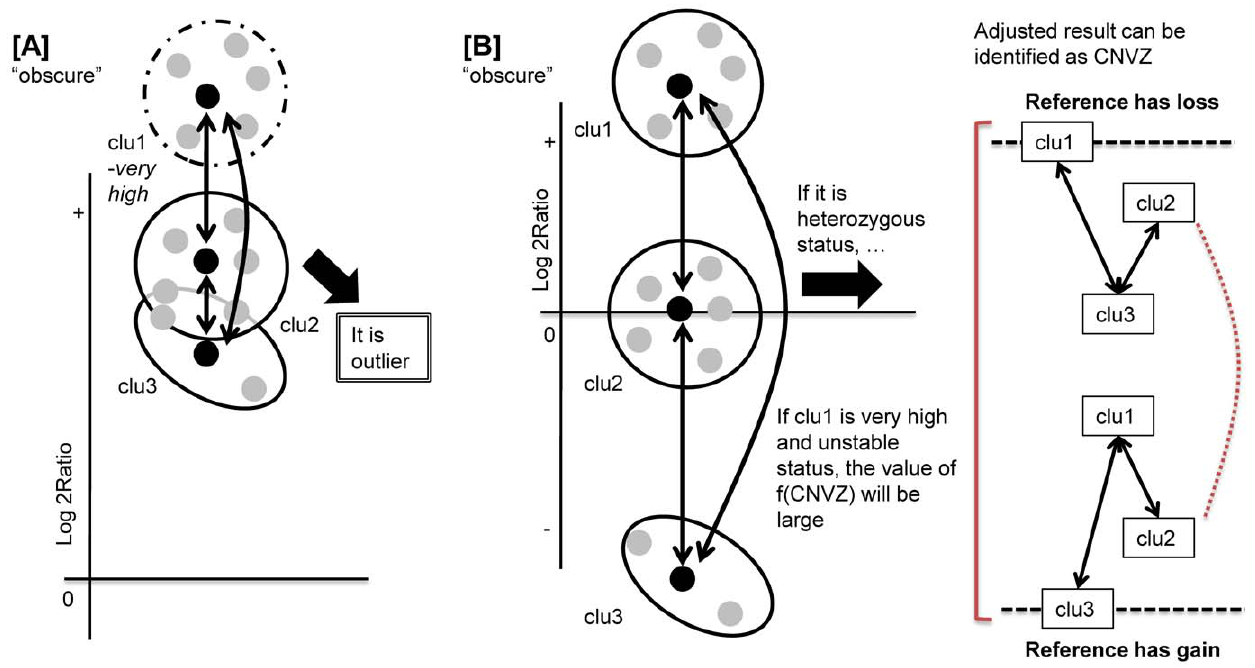
Figure 11. Schemes to consider the reference copy number in MGVD. The left Figure [A] indicates case 1, which has a complete loss in the reference. MGVD detects these cases as neutral. The right Figure [B] indicates case 2, which has a heterozygous copy number compared with the test sample. MGVD detects these cases as CNVZs.